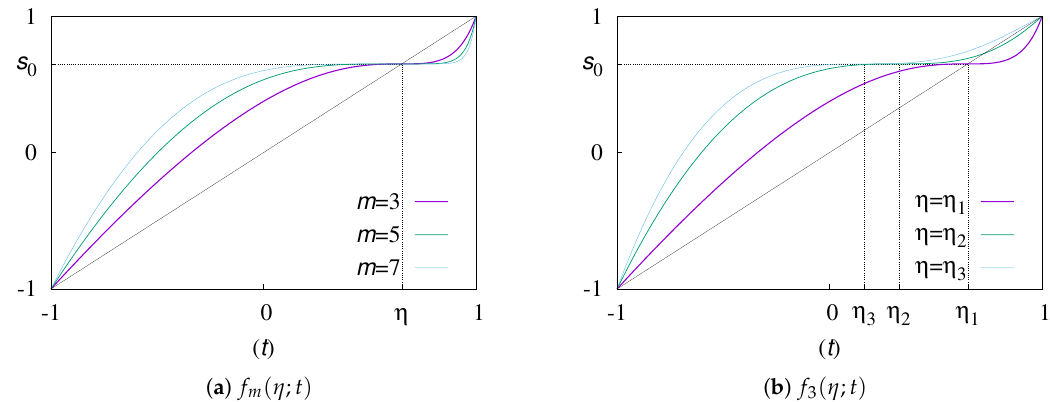
(in Figure 1b) the condition (14) becomes η ≥ − 4 bettered integrands whose behaviors are respectively O near t = η .